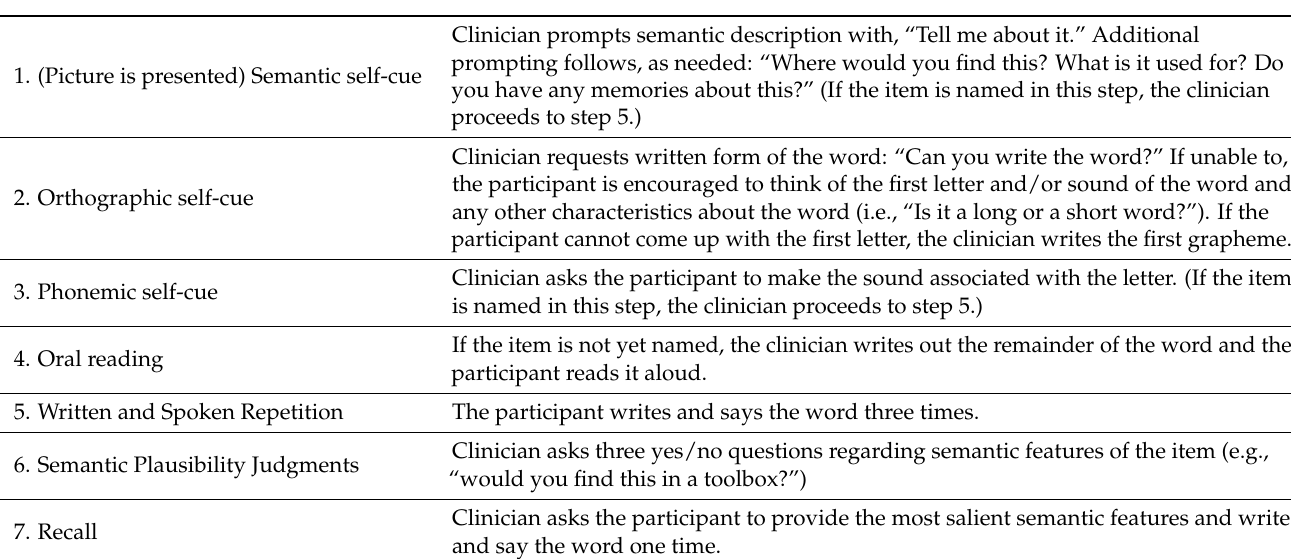
Table 3. Lexical Retrieval Cascade Used During Treatment Sessions (Henry et al., 2013;